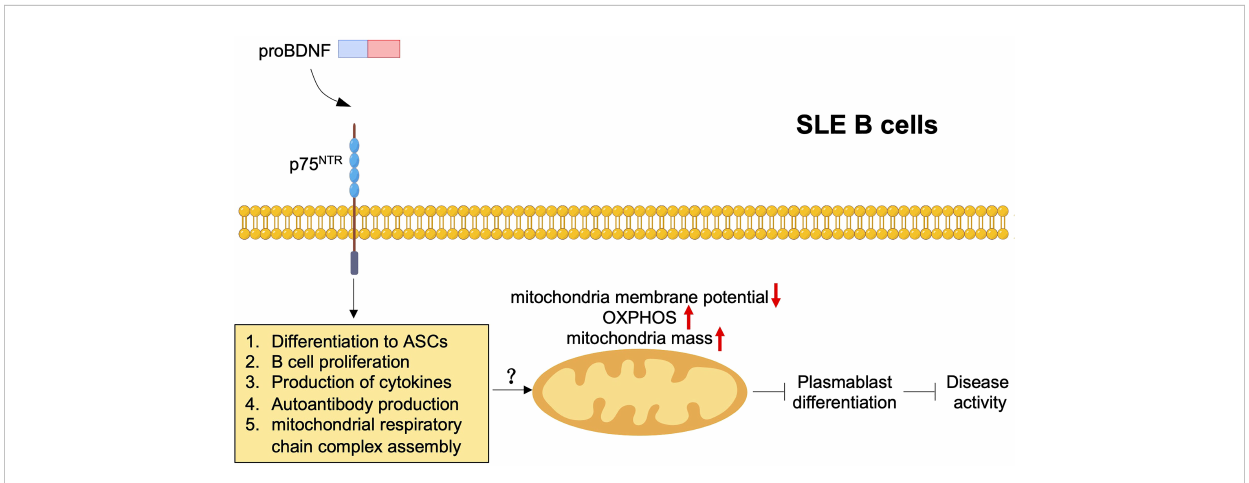
FIGURE 5 ProBDNF/p75 NTR signaling in SLE B cells. ProBDNF/p75 NTR signaling promotes B cell differentiation, proliferation, release of proin fl ammatory cytokines and autoantibody production and mitochondrial respiratory chain complex assembly. Mitochondria damage and dysfunction including decreased mitochondria membrane potential and enhanced OXPHOS and mitochondria mass, which may increase disease activity through inhibiting plasmablast differentiation by proBDNF/p75 NTR signaling